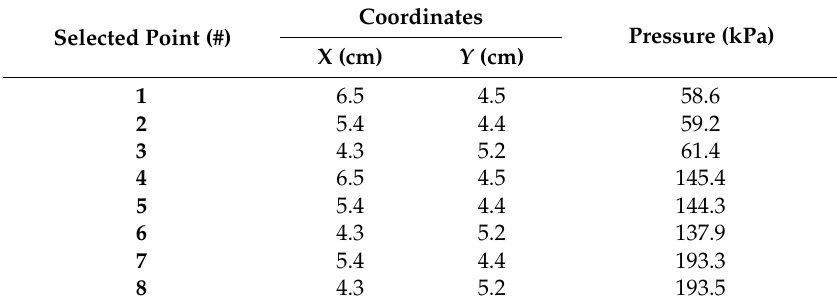
Table 1. The number, coordinates, and pressure values of 8 typical test data